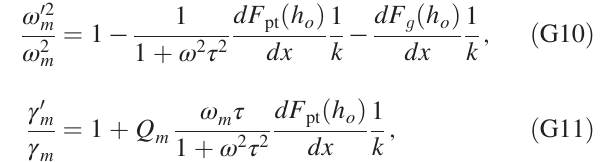
ð h Þ and ω 0 ð h Þ . m m